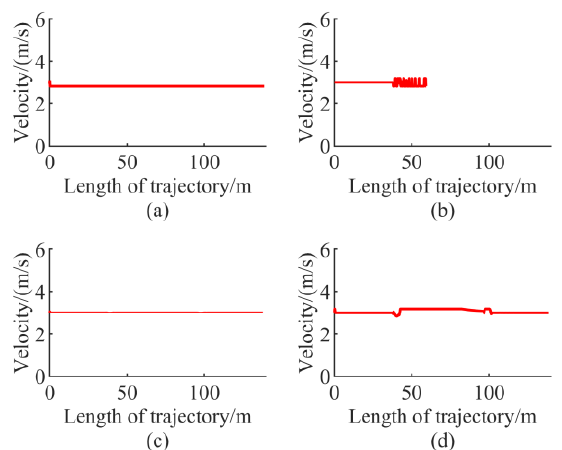
Figure 8. The velocity when velocity is 3 m / s. ( a ) LMPC. ( b ) LEMPC. ( c ) NMPC. ( d ) NEMPC.